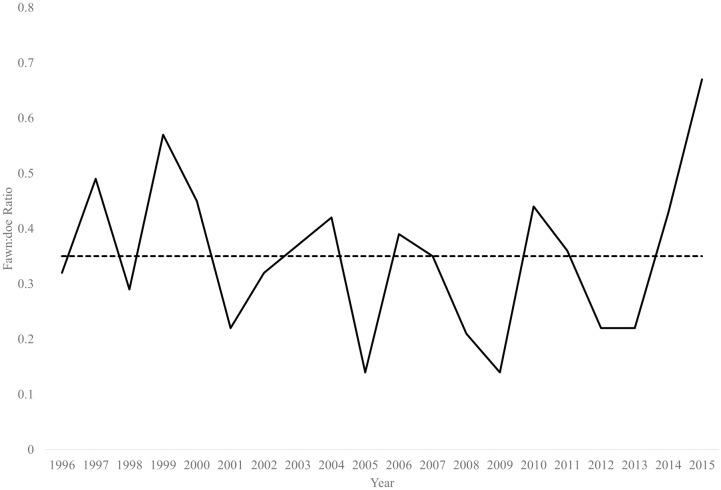
Fawn:doe ratios observed during helicopter surveys in South Texas, 1996–2015.Horizontal line indicates mean fawn:doe ratio.